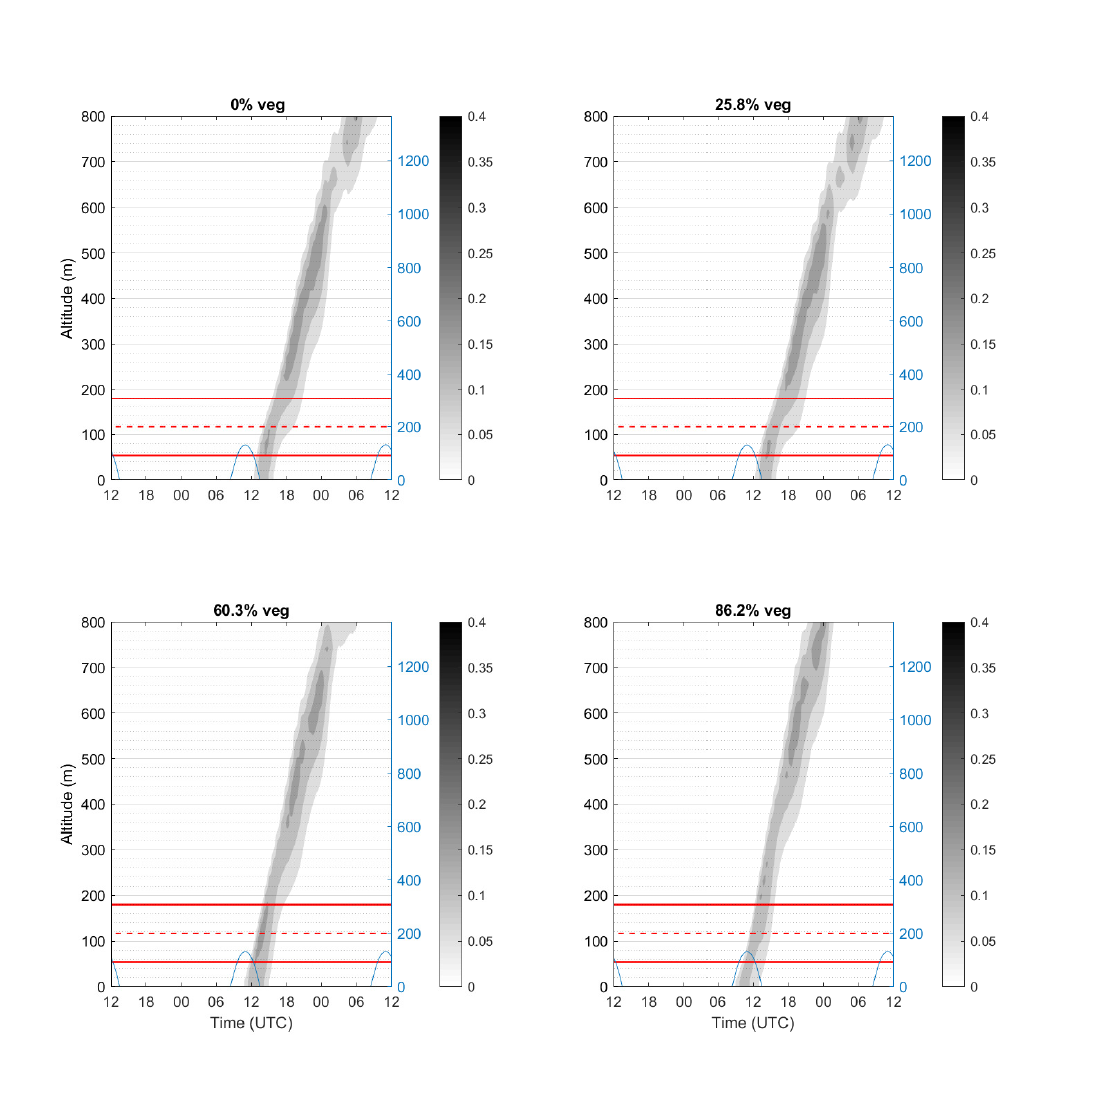
Figure 15. Time-height cross section of cloud water content (g/kg, filled contours) for the 24 December 2013 case for vegetation fractions of 0%, 25.9%, 60.4%, and 86.3%, respectively, using the Single Layer SBL scheme. Since the qualitative changes to the cloud evolution for each successive vegetation fraction in this case were roughly continuous, four vegetation fractions from bare ground to the reference case with the largest fraction of vegetation were shown here for illustrative purposes. Top of the atmosphere downwelling shortwave radiation (W/m 2 , right y-axis) has been added to indicate the diurnal cycle. The red lines indicate the elevation of a hypothetical wind turbine with a hub height of 117 m (dashed lines) and a rotor diameter of 126 m (solid lines indicating turbine